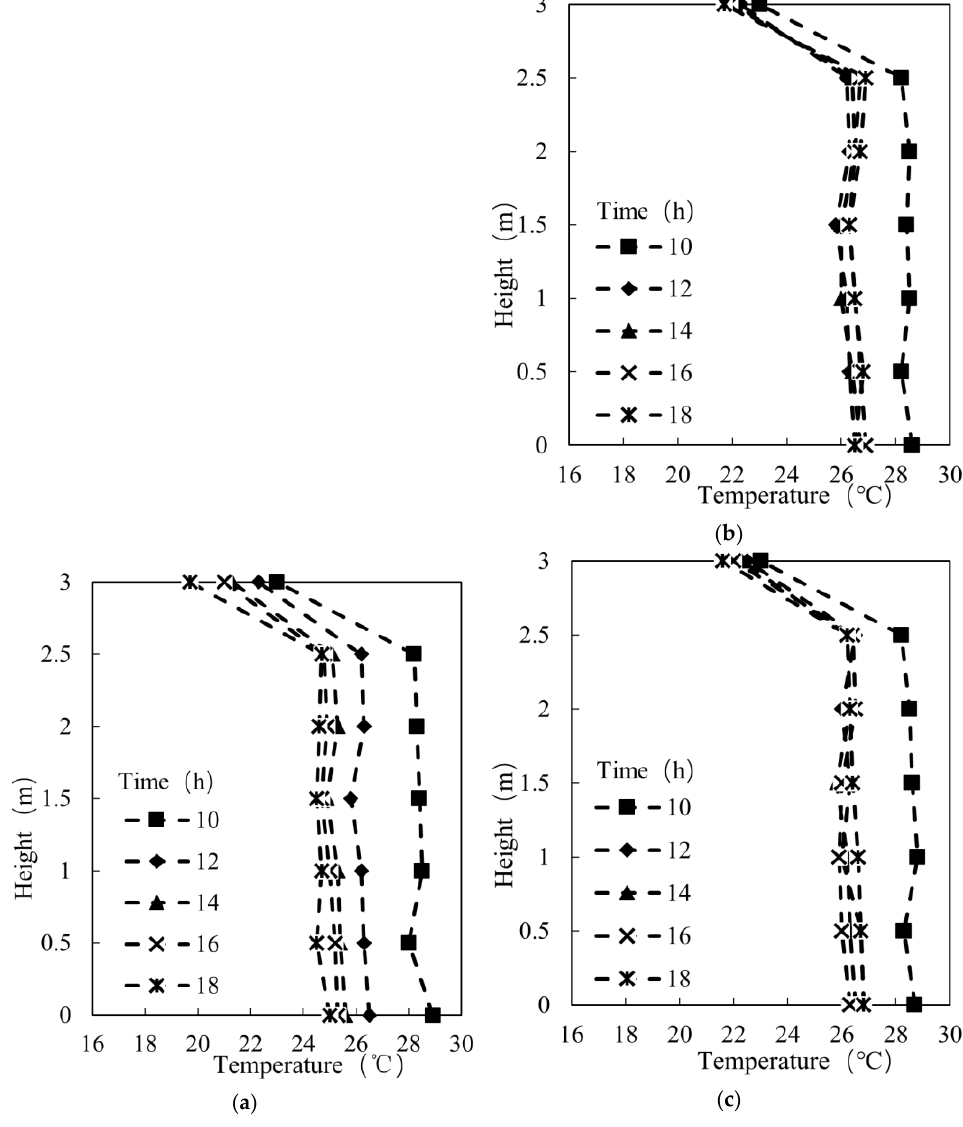
Figure 17. Temperature distribution in the vertical direction. ( a ) Vertical temperature distribution under constant condition control; ( b ) vertical temperature distribution under constant flow control; ( c ) vertical temperature distribution under constant temperature control.